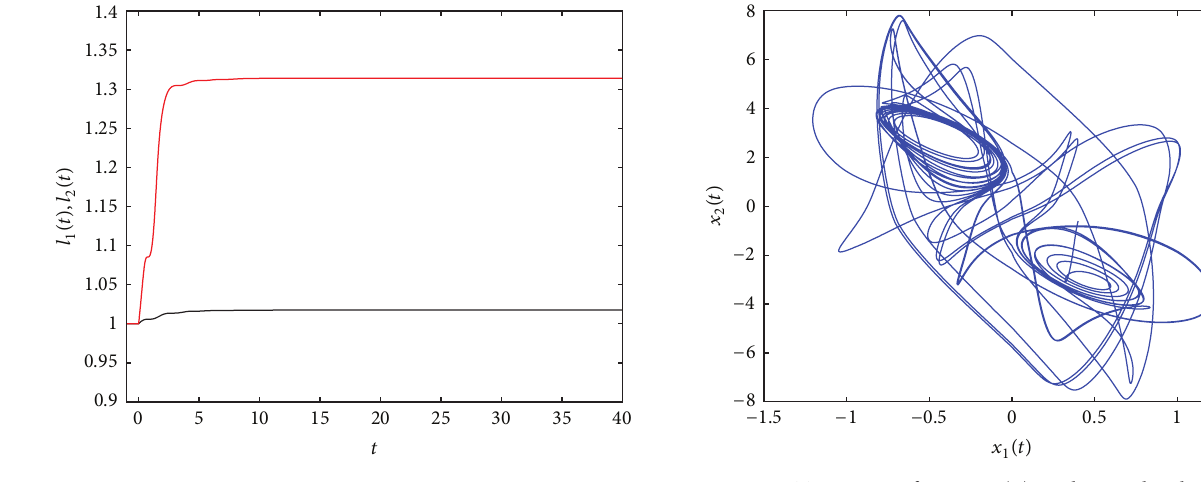
Figure 4: Trajectory of system (∗) with initial value 𝑥(𝑡) = (0.4, −0.6) 𝑇 , 𝑡 ∈ [−1,0]